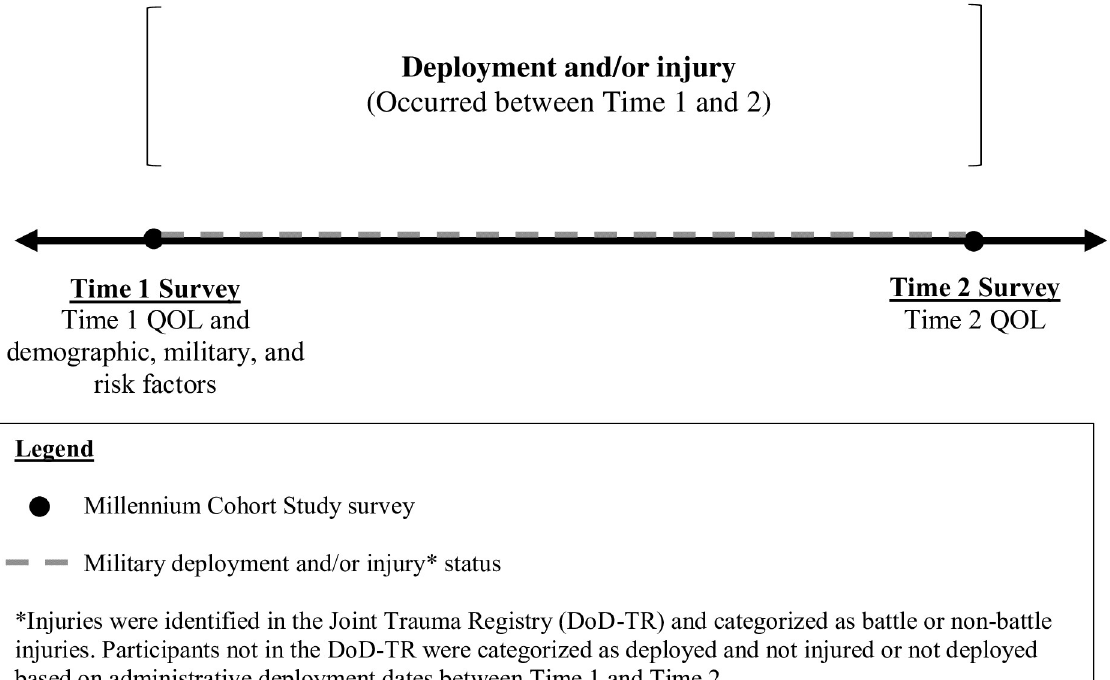
Fig 1. Timeline for the deployment and injury status on quality of life